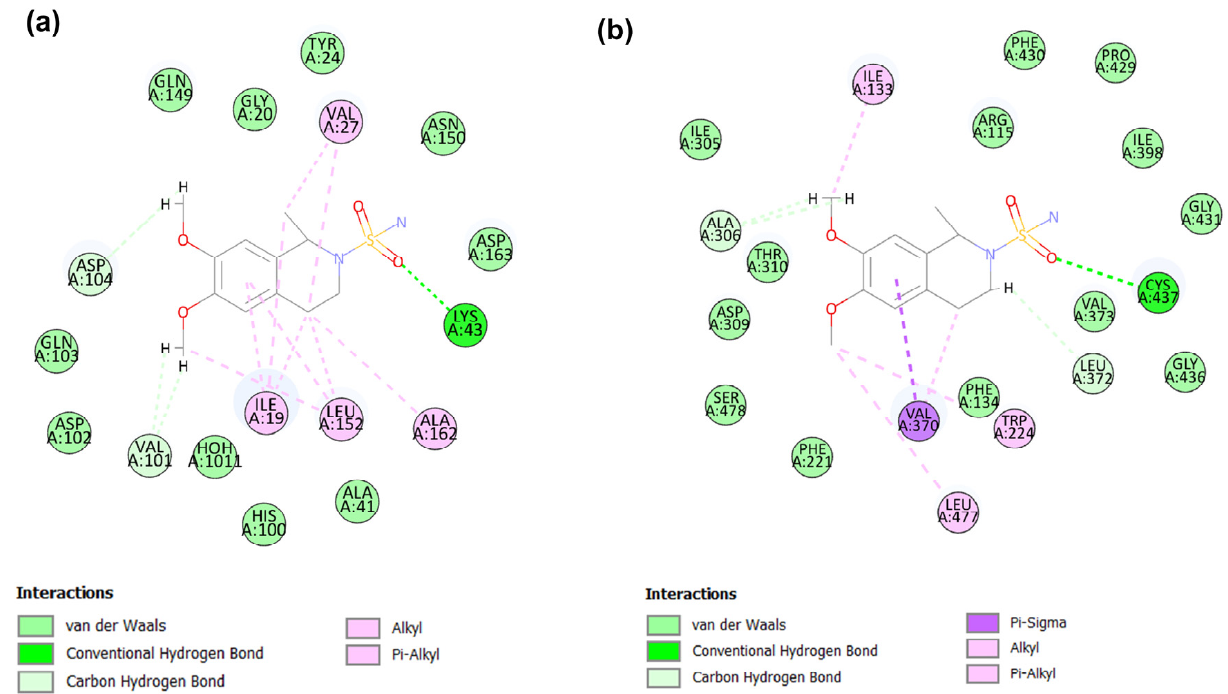
Figure 9. The 2D plot of candidate 3 in CDK ( a ) and aromatase ( b ) at the binding site.